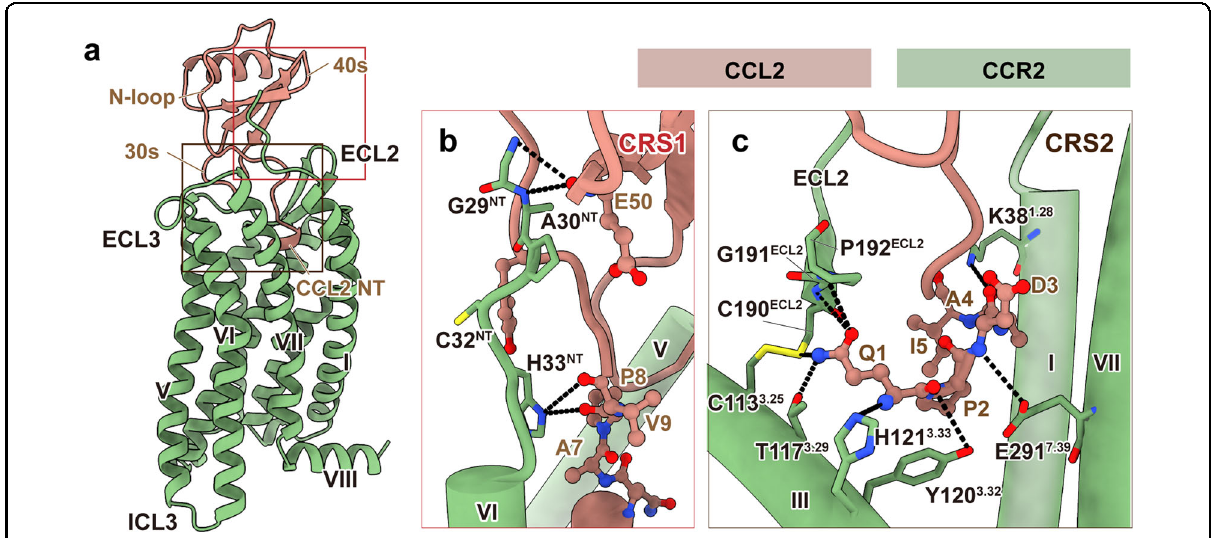
Fig. 2 The orthosteric chemokine-binding pocket of CCR2. a Side view of CCR2 (green) bound to its endogenous ligand CCL2 (brown). b , c Details of interactions between CCR2 and CCL2 at the CRS1 ( b ) and CRS2 ( c ) regions. Hydrogen bonds are depicted as black dashed